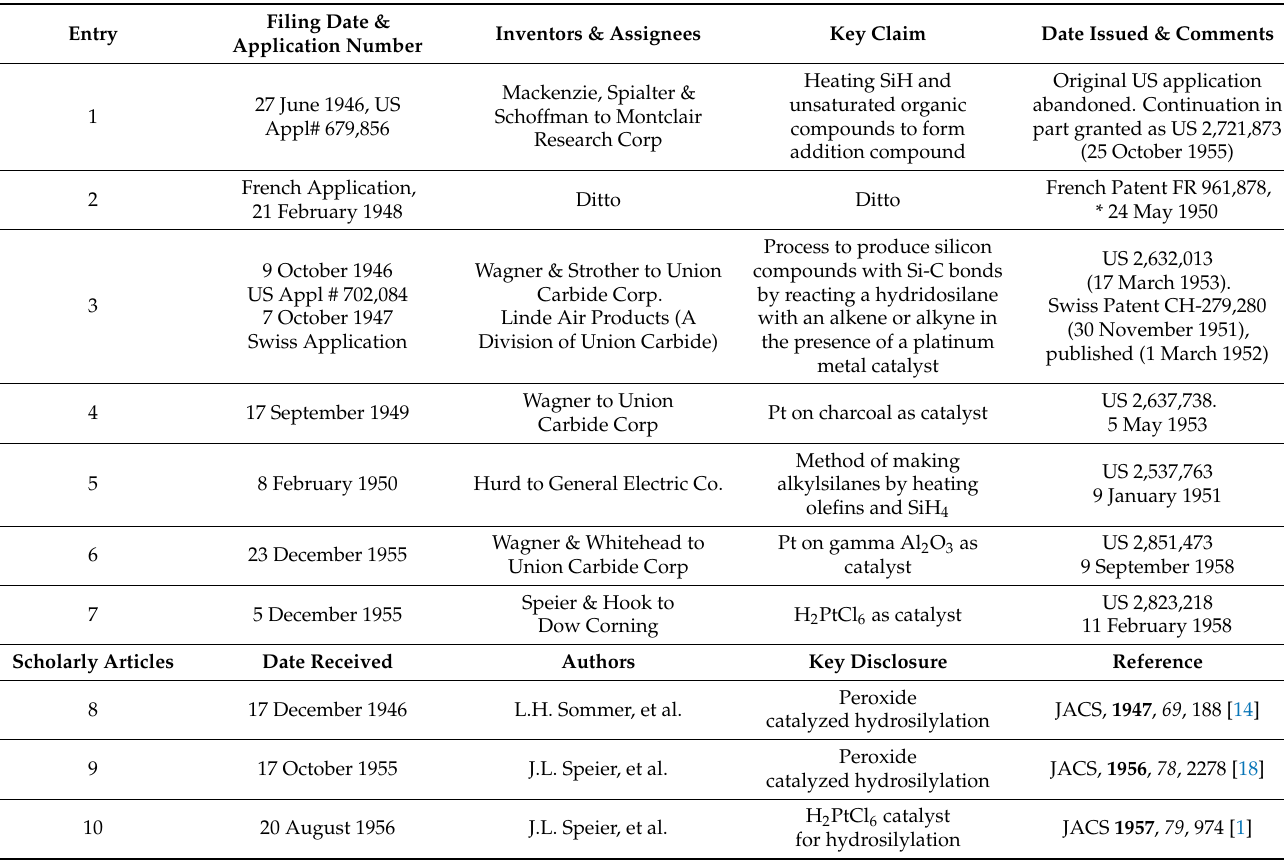
Table 1. Key patents § and publications in the history of